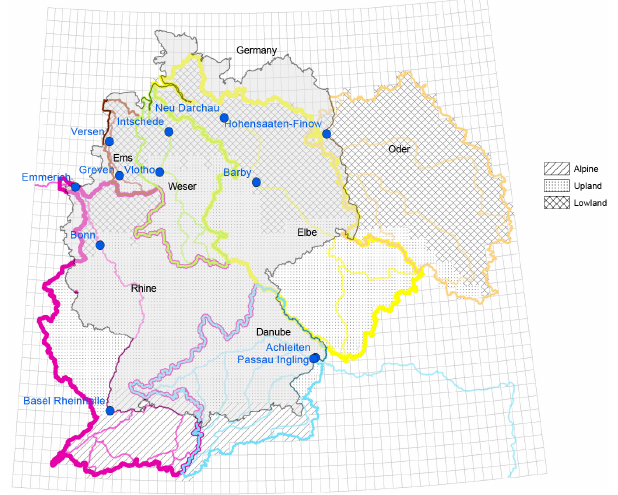
Figure 1. Study area: delimitation of the basin boundaries of the Rhine, Danube, Elbe, Weser, Oder, and Ems basins and subdivi- sion into alpine, upland, and lowland. The background raster corre- sponds to the E-OBS data set. Gauging stations at the outlet of each sub-basin are represented with blue